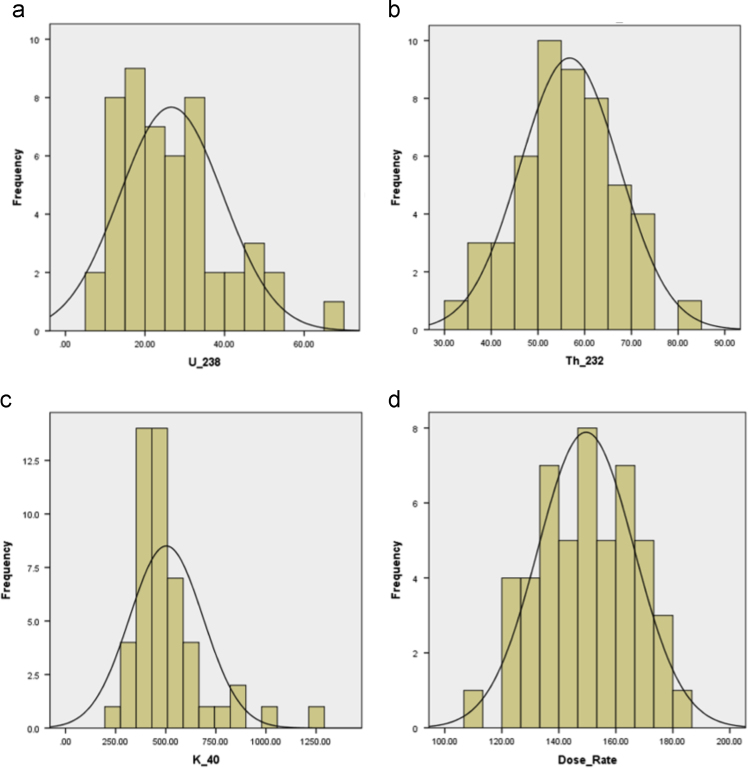
Histogram plots for (a) 238U (b) 232Th (c) 40K (d) gamma-radiation dose rate.